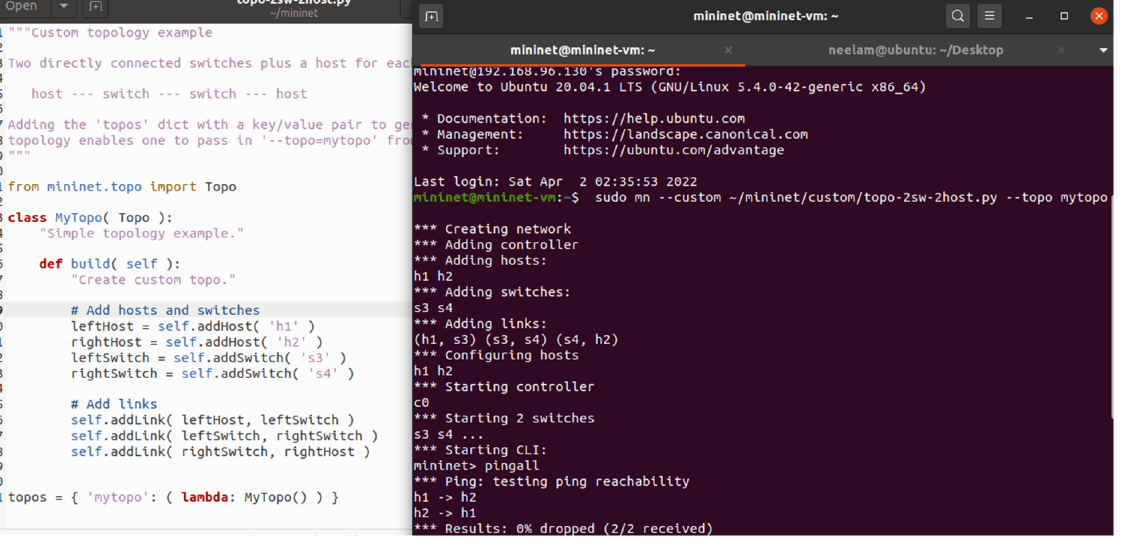
Figure 19. Basic command for custom topology on Mininet.